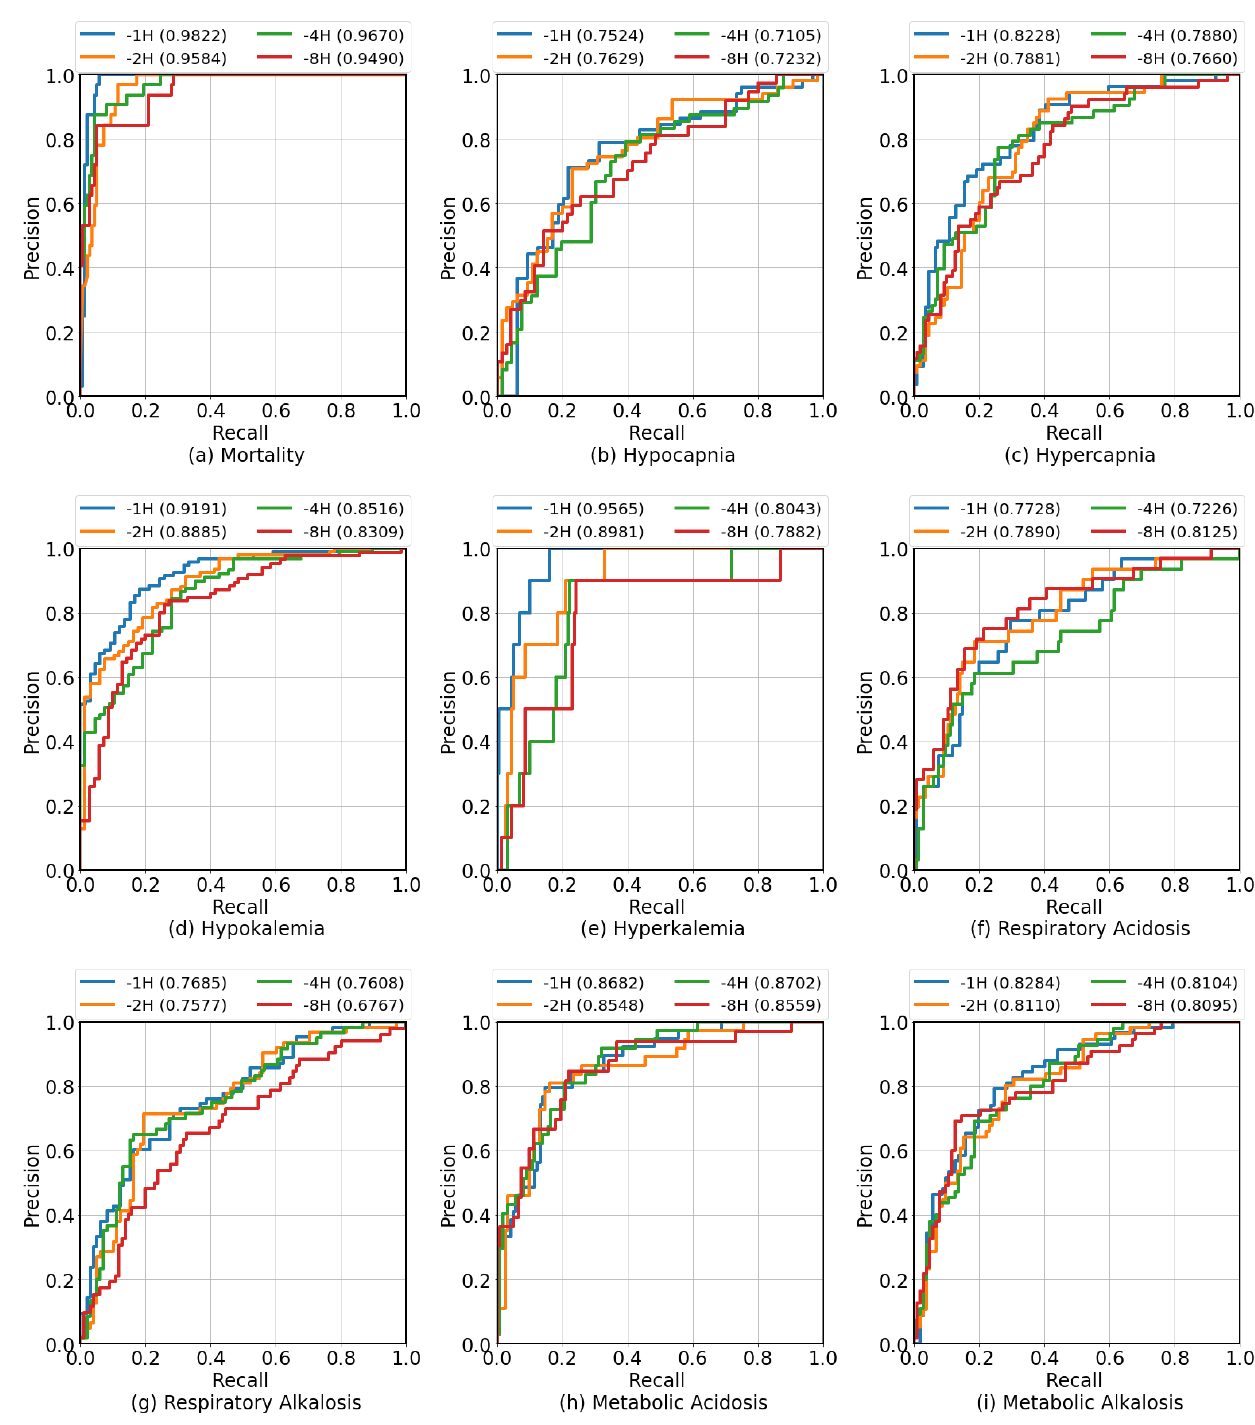
Figure 5. The ROC curves compare different early prediction periods (1, 2, 4, and 8 h before onset) using GB for each target clinical